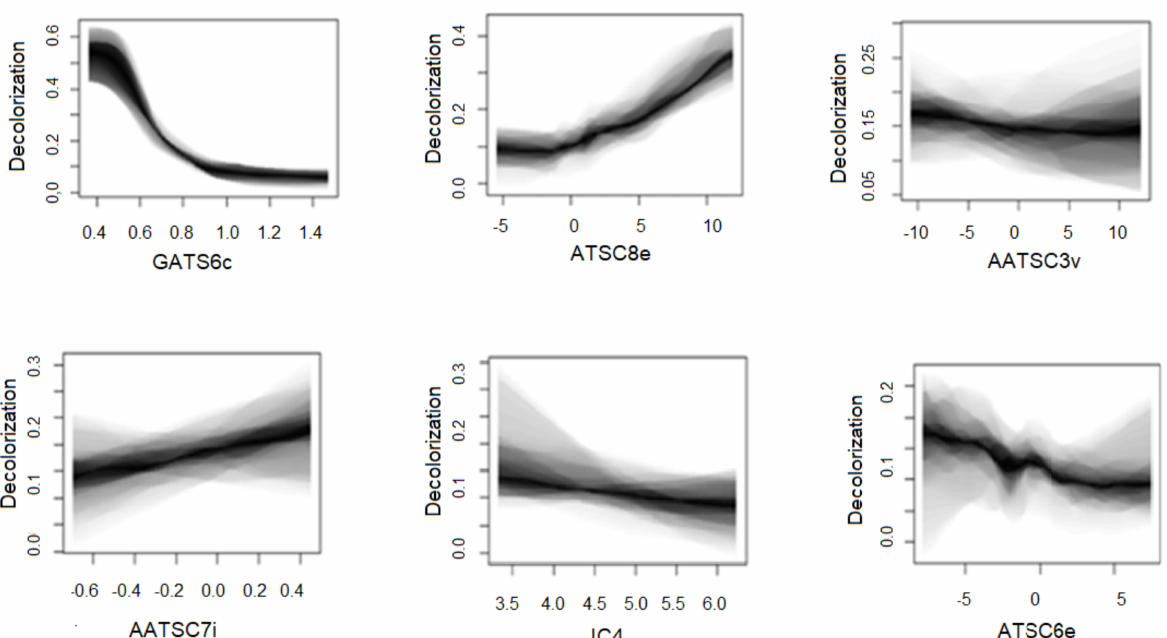
Figure 2. Observed marginal distributions as partial dependency plots of dyes decolorization by LPMO depending on the key molecular descriptors. GATS6c—2D Geary coefficient of lag 6 weighted by Gasteiger charge, ATSC8e—2D Broto-Moreau autocorrelation of lag 8 (log function) weighted by electronegativity, ATSC6e—2D Broto-Moreau autocorrelation of lag 6 (log function) weighted by electronegativity, AATSC3v—averaged and centered Moreau-Broto autocorrelation of lag 3 weighted by van der Waals volume, AATSC7i—averaged and centered Moreau-bro to the autocorrelation of lag 7 weighted by ionization potential, IC4—4-ordered neighborhood information content.